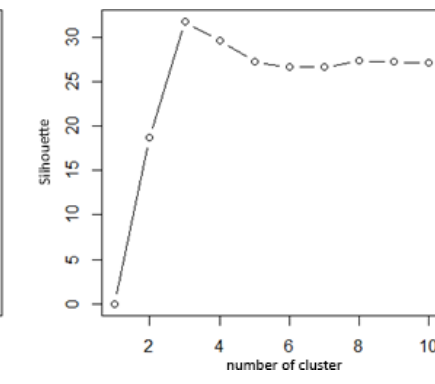
correlation with the black mica schist end-member.